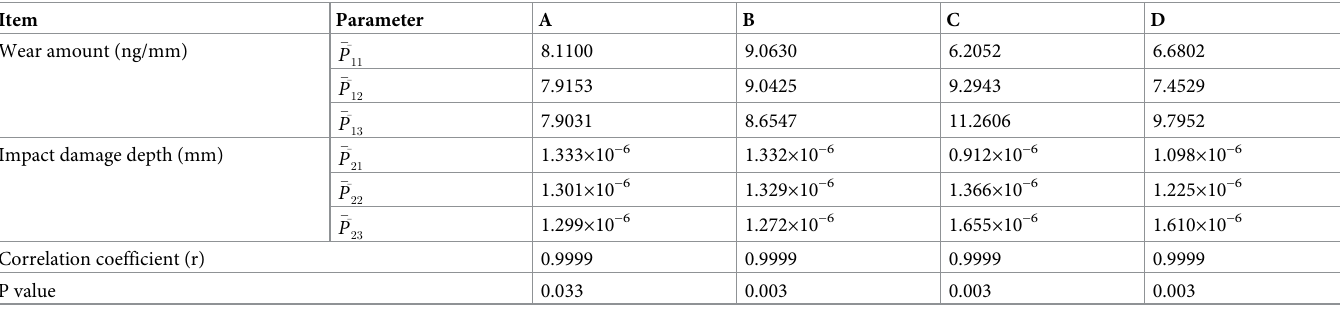
Table 14. Correlation of the wear amount of the middle trough measured in the experiment with the impact damage depth obtained in the OMA simulation.